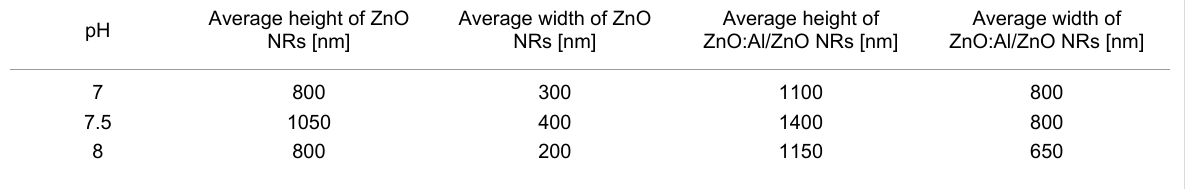
Table 1: Average sizes of ZnO NRs and ZnO NRs covered ZnO:Al grown at different pH values.